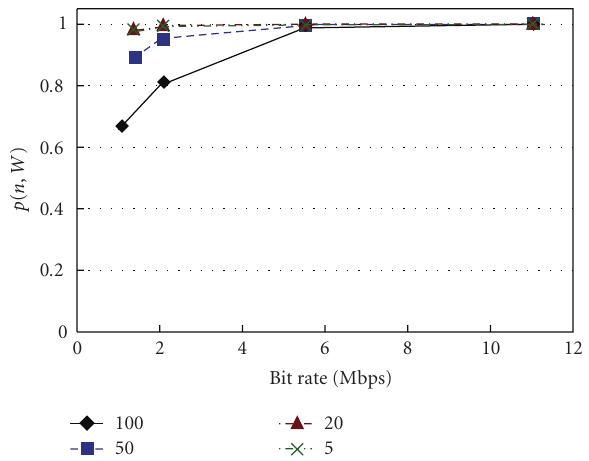
Figure 3: Successful beacon transmission rate of 802.11g (20 microsec).